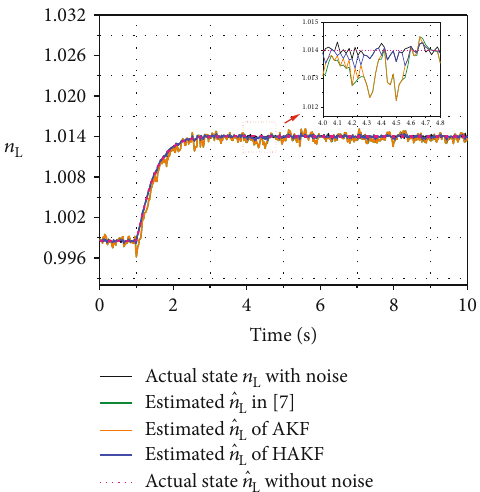
Figure 10: State n L and its estimations of three